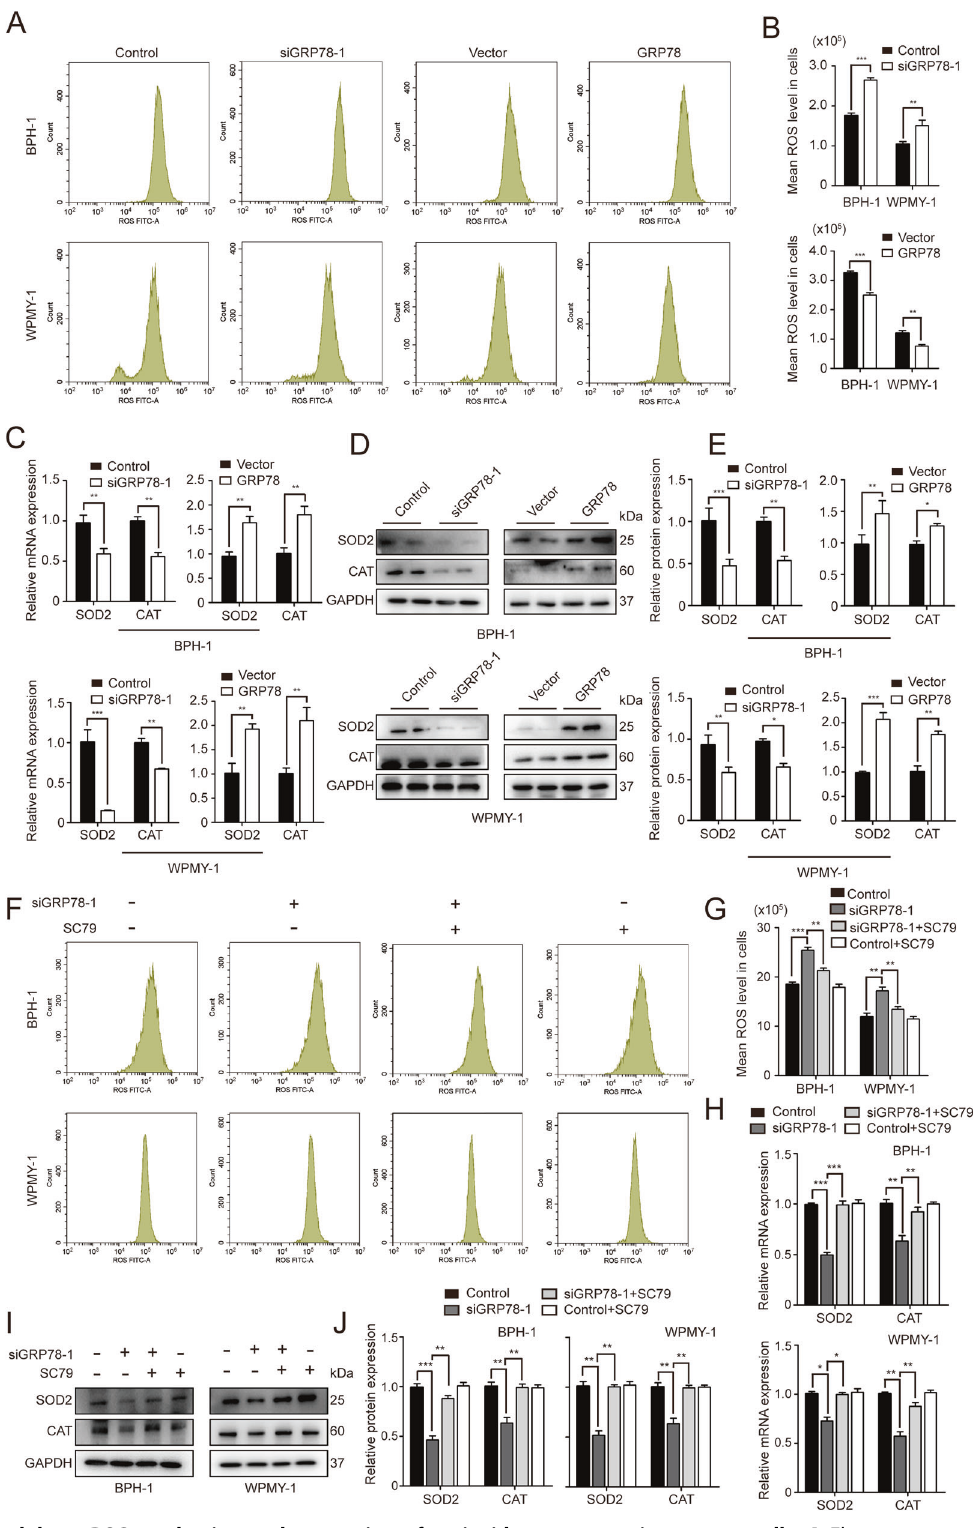
Fig. 7 GRP78 modulates ROS production and expression of antioxidant enzymes in prostate cells. A Flow cytometry analysis for ROS generation in BPH-1 and WPMY-1 cells with either GRP78 knockdown or GRP78 overexpression. B The statistical analysis for mean ROS level. C The mRNA levels of SOD2 and CAT in both prostate cell lines after transfection by qPCR. D , E Immunoblot assay and relative densitometric quanti fi cation for SOD2 and CAT in prostate cells. F , G Flow cytometry analysis for ROS generation of BPH-1 and WPMY-1 cells. Two lines were transfected with siRNA and treated with/without SC79. The mean ROS level was statistically analyzed. H , I The mRNA and protein levels of SOD2 and CAT in two lines treated with siRNA and with/without SC79. J Relative densitometric quanti fi cation of SOD2 and CAT. GAPDH is used as loading control. * p < 0.05; ** p < 0.01; *** p <